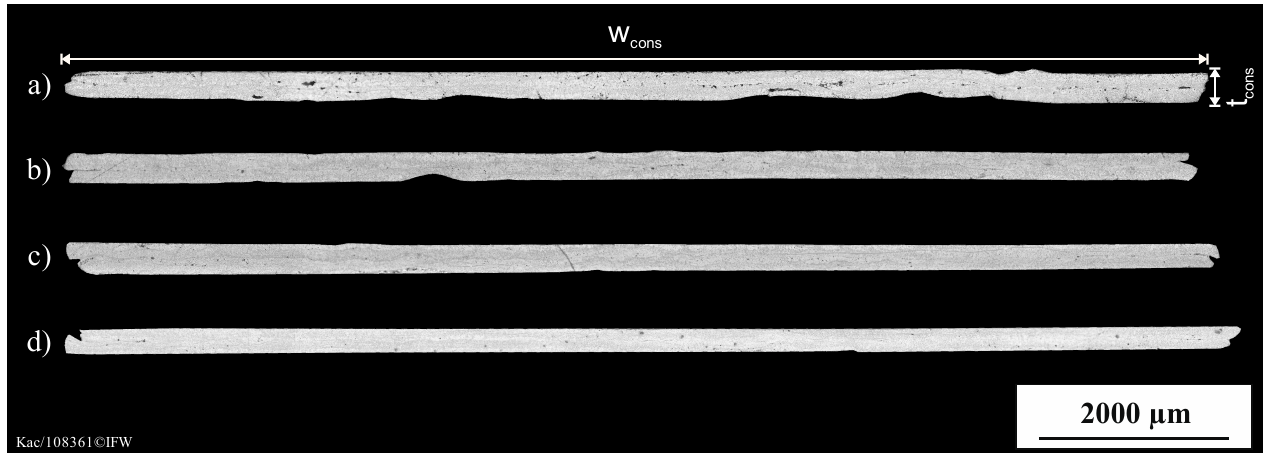
Figure 4. Representative Laser Scanning Microscopy (240 × magnification, stitched) of the cross-sectional area of the